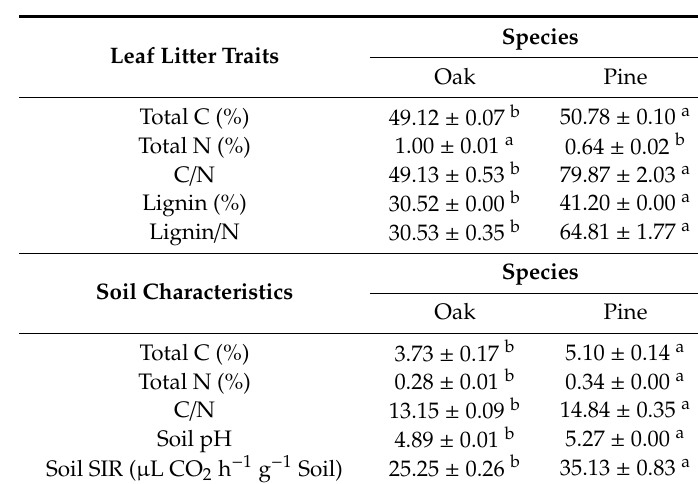
Table 2. Initial physicochemical properties of the fresh leaf litter (oak and pine) and soil from the oak and pine forests (means ± SD, n =